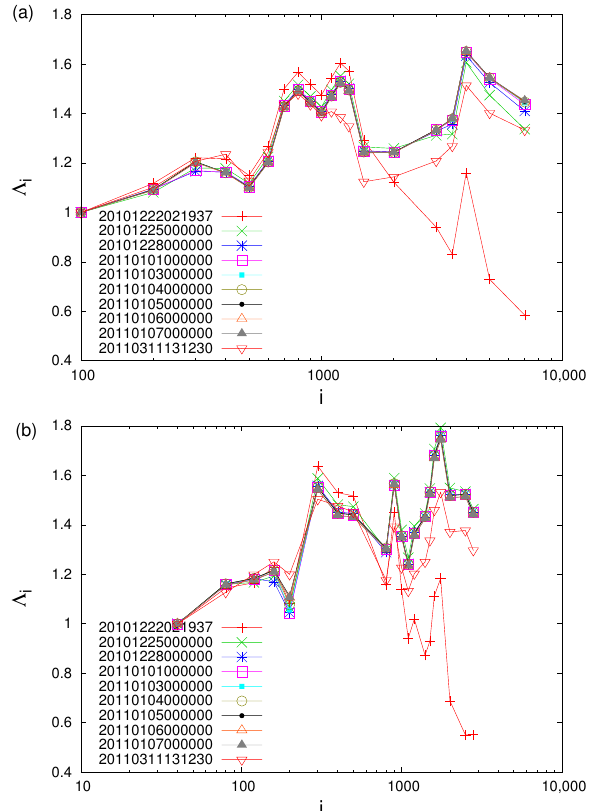
Figure 27. The values of Λ i versus the scale i , as in Figure 22, for various ending dates in the last week of December 2010 and in the first week of January 2011, see the inset, when considering the M JMA ≥ 3.5 EQs ( a ) or the M JMA ≥ 4.0 EQs ( b ) in the large region N 46 on 1 January 2010. Taken from Ref.